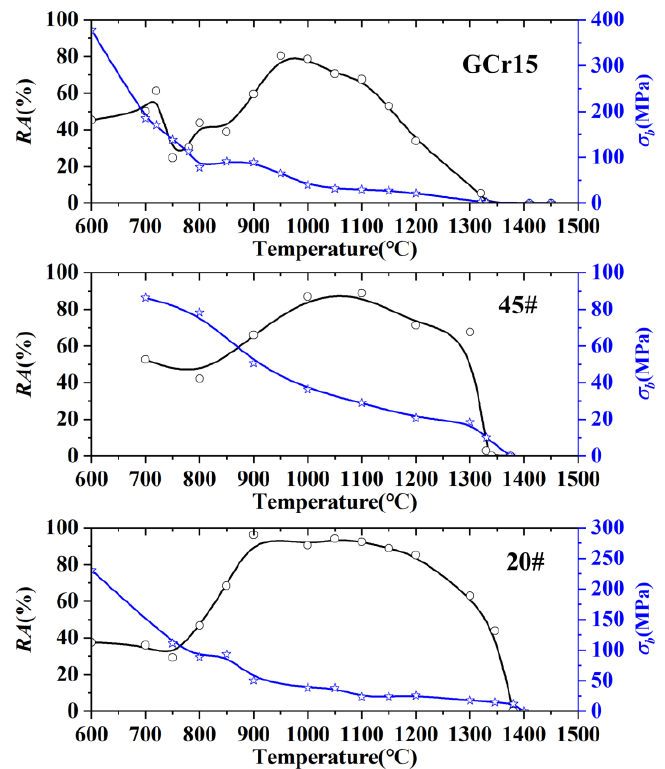
Figure 6. High-temperature strength of steels.